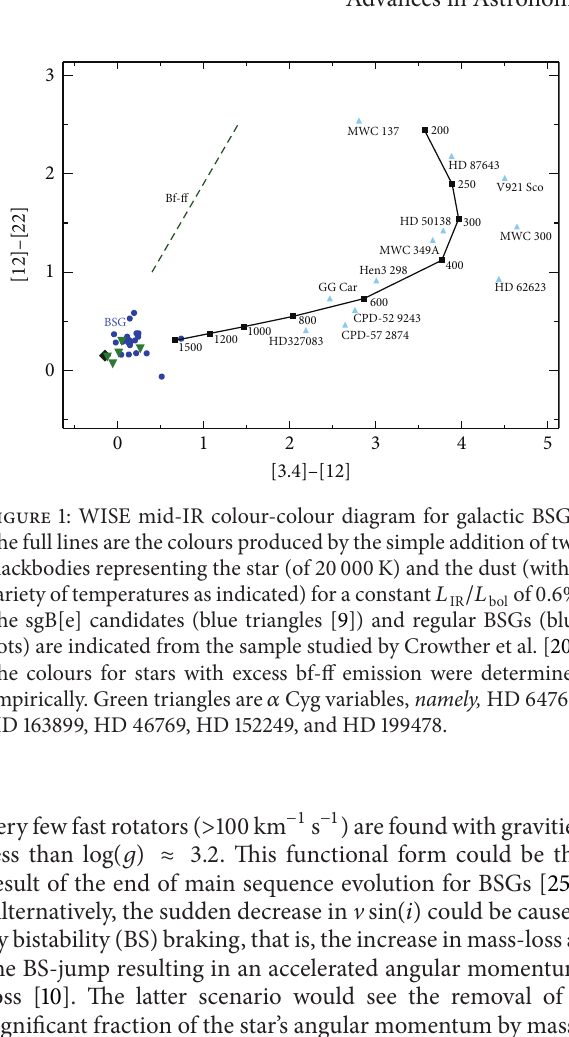
/𝐿 of 0.6%. IR bol